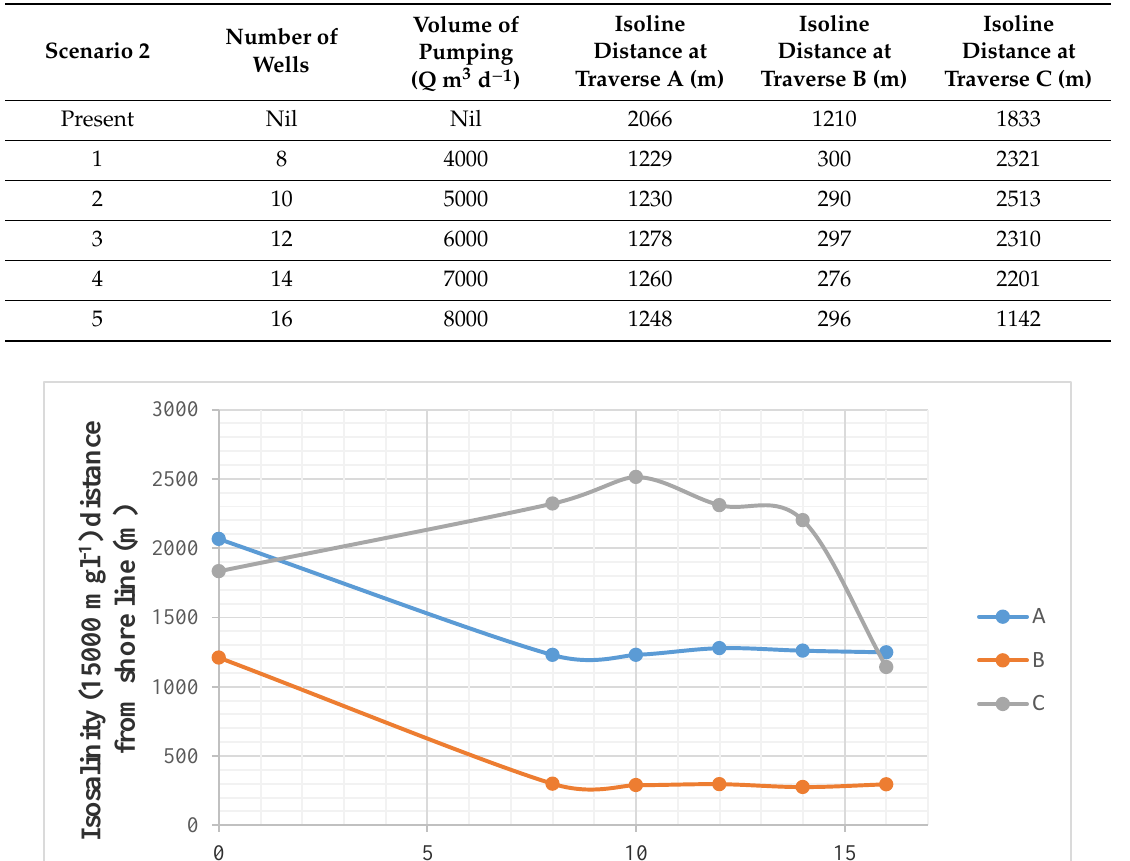
Table 4. Distance of 15,000 mg L − 1 Isosalinity Contour along Traverse A, B and C using a Variable